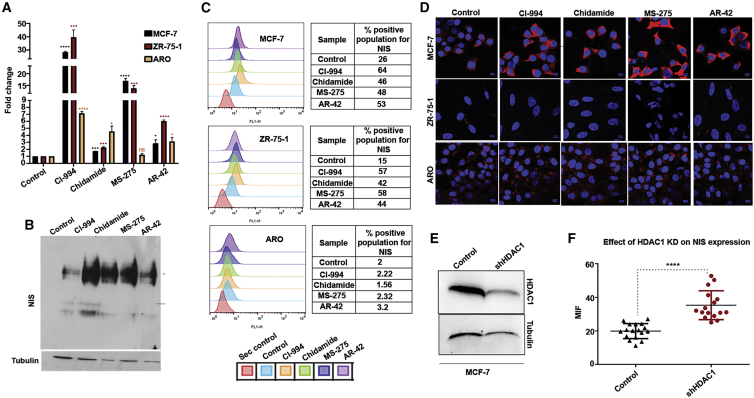
bHDACi Induces NIS Expression Specifically in BC Cells, but Not in Normal Breast or TC Cells(A) Graphs showing fold difference in NIS transcript levels for ZR-75-1, MCF-7, and ARO cell lines post-bHDACi treatment with respect to their untreated counterparts. Error bar represents SEM; significance determined by t test. ∗p ≤ 0.05; ∗∗∗p ≤ 0.001; ns, non-significant. (B) Semiquantitative western blot showing increased NIS expression (100-kDa band) post-bHDACi treatments for 48 h. (C) Data showing NIS-positive cell population after bHDACi treatment. Peaks that shift toward right on the x axis indicate increased FITC-positive populations. Table indicates percentage positive cell calculated from the histograms. (D) Immunofluorescence photomicrographs showing the NIS protein expression detected by using Dylight 633-labeled secondary antibody (red) in MCF-7, MCF-10A, and ARO cells. Blue indicates DAPI staining. Scale bar shows 10 μm distance. (E) HDAC1 protein expression in MCF-7 cells before and after knockdown of HDAC1. (F) Graph showing the MFI from individual control and HDAC1 knockdown cells (n = 30). ∗∗∗p ≤ 0.001.